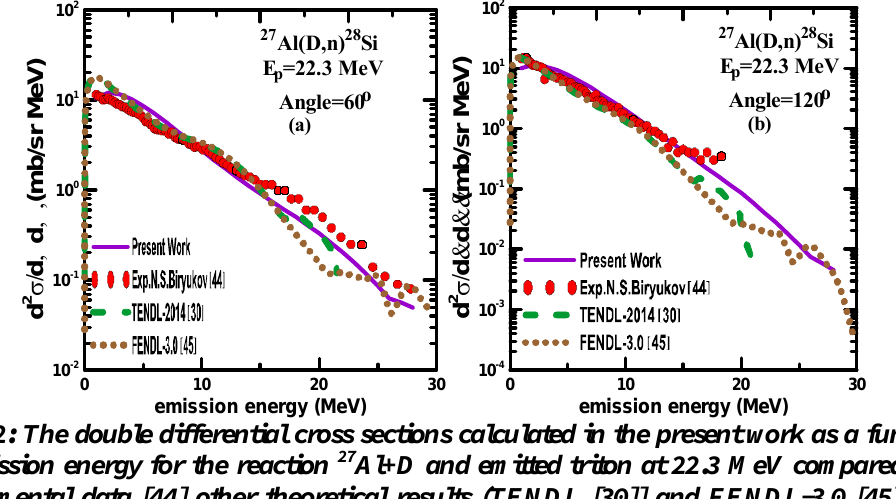
Fig. 12: The double differential cross sections calculated in the present work as a function of emission energy for the reaction 27 Al+D and emitted triton at 22.3 MeV compared with experimental data [44] other theoretical results (TENDL [30]] and FENDL-3.0 [45]) and different emission, (a) angle 60 0 and (b) angle 120 0